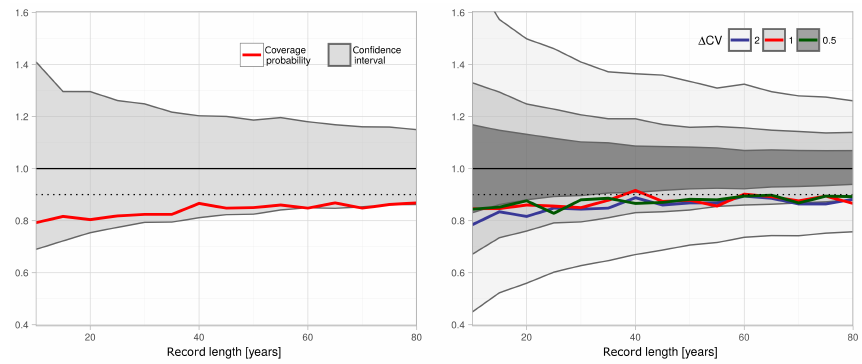
Figure 6. The average confidence intervals (relative to the long-term mean R factor, 669MJha − 1 mmh − 1 ; grey area) and the coverage probability (thick lines) for different record lengths based on station C2TREB01 – Tˇreboˇn (left panel) and simulated data (right panel). The dotted line corresponds to the coverage probability of